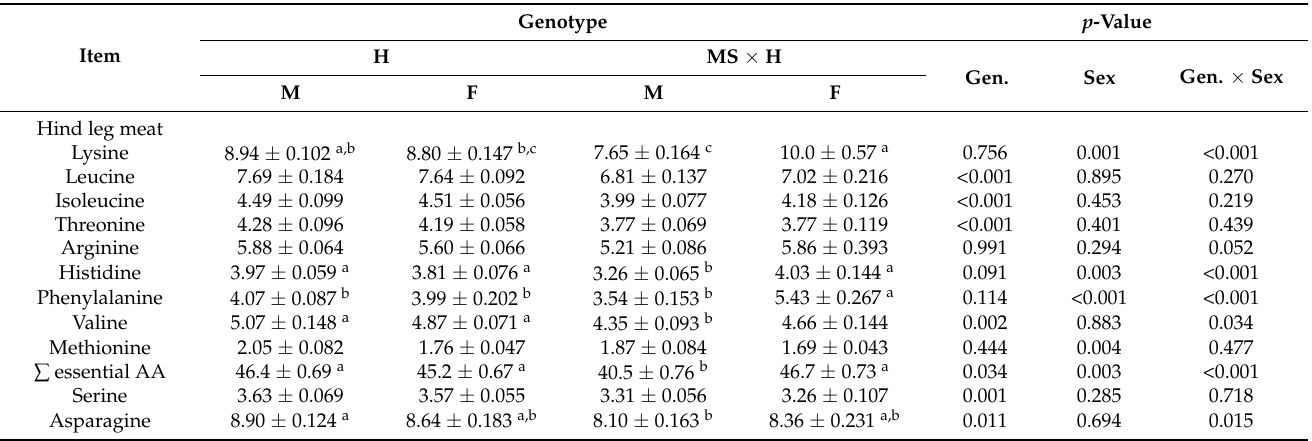
Table 4. Amino acid profile (g/100 g of total crude protein) of rabbit meats in relation to the genotype and